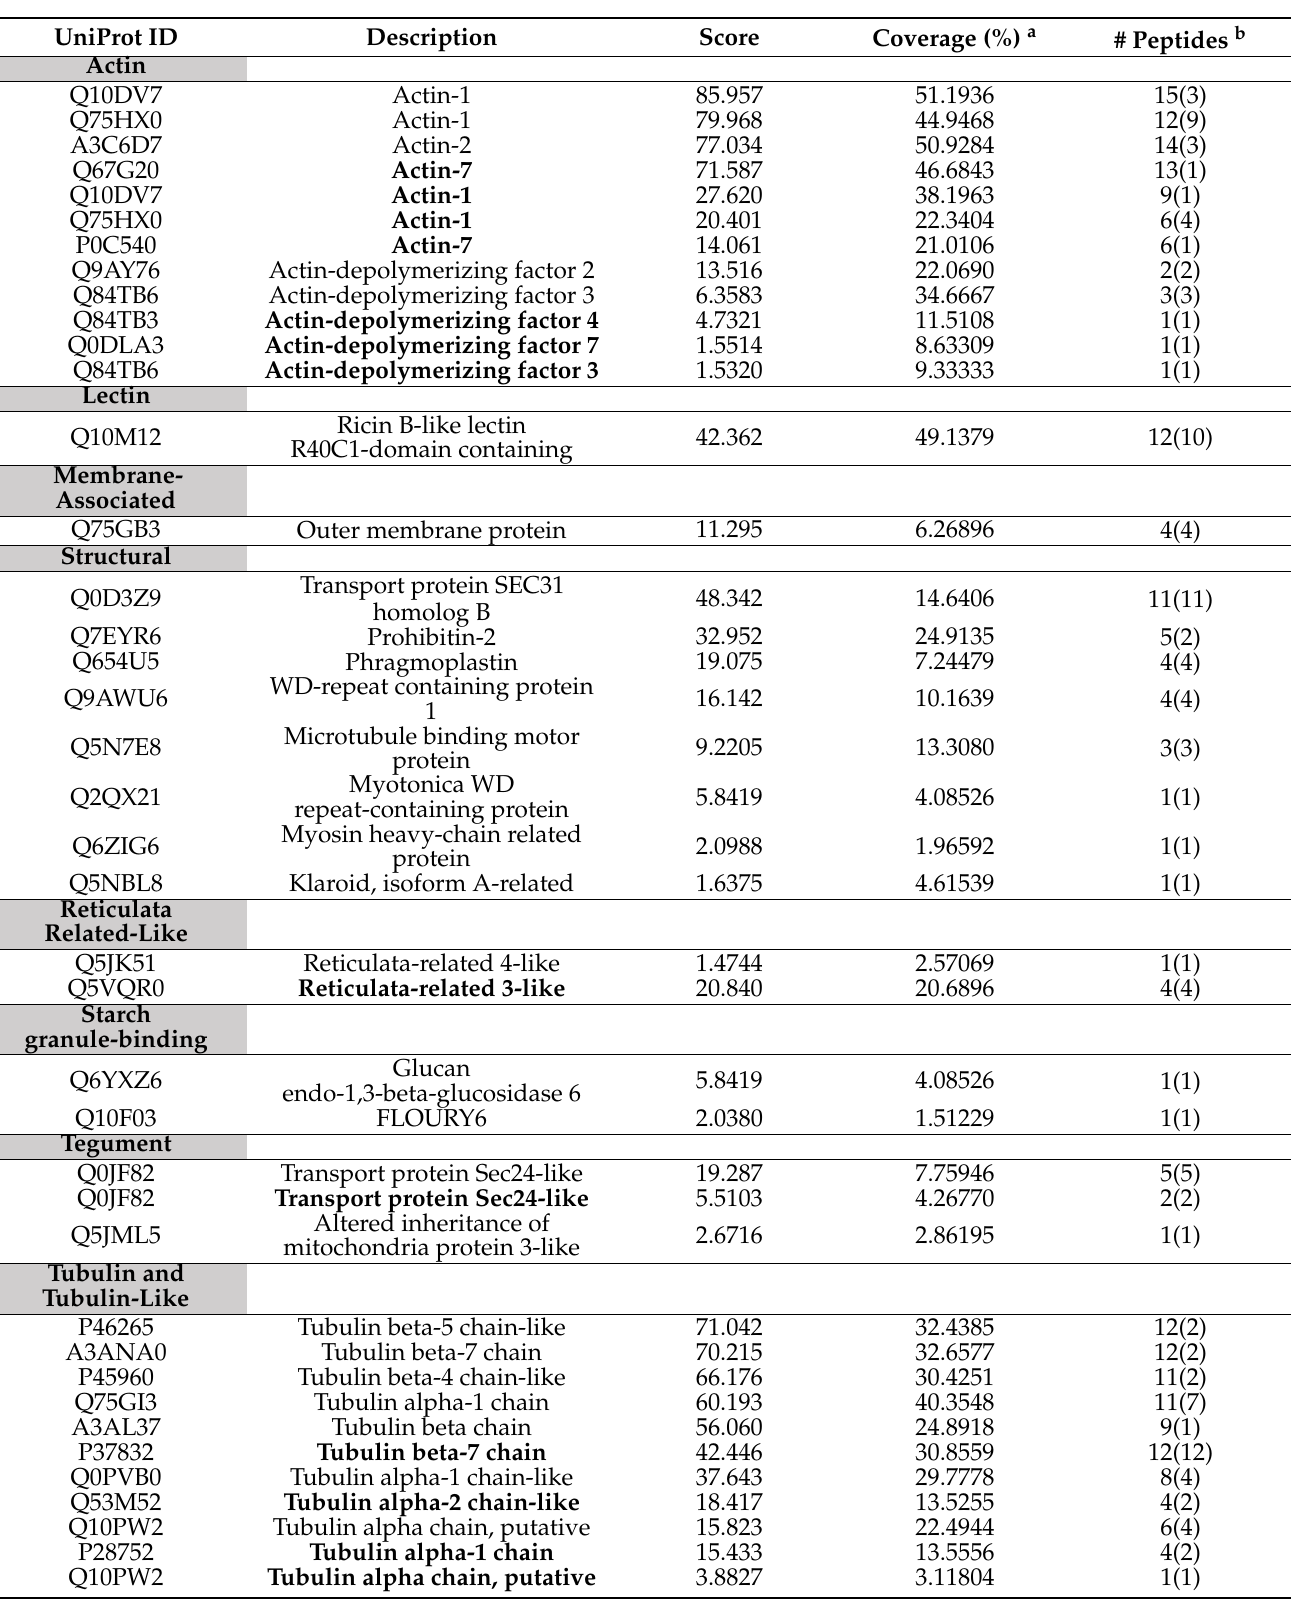
Table 3. Plastoskeletal proteins from dispersion-method-prepared starch